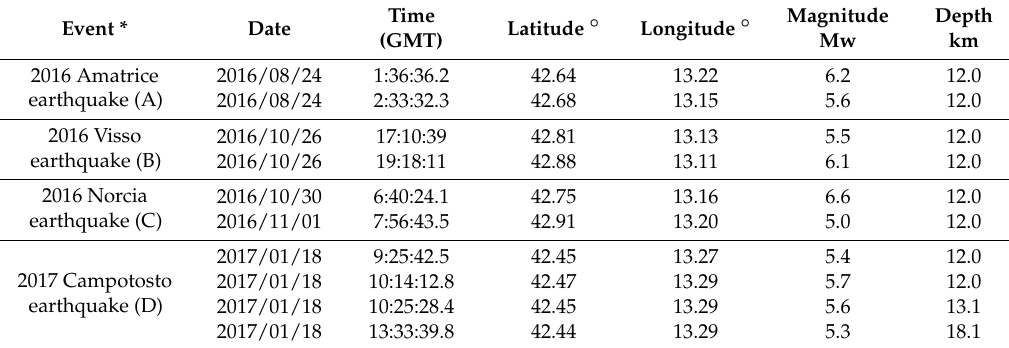
Table 1. Catalogue of the 2016–2017 Central Italy earthquake sequence (GCMT